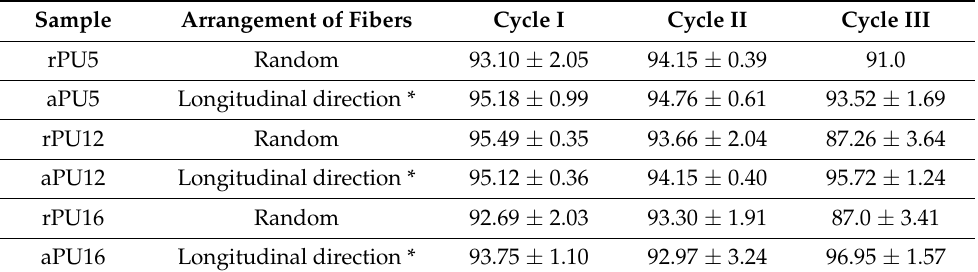
Table 6. Values of shape